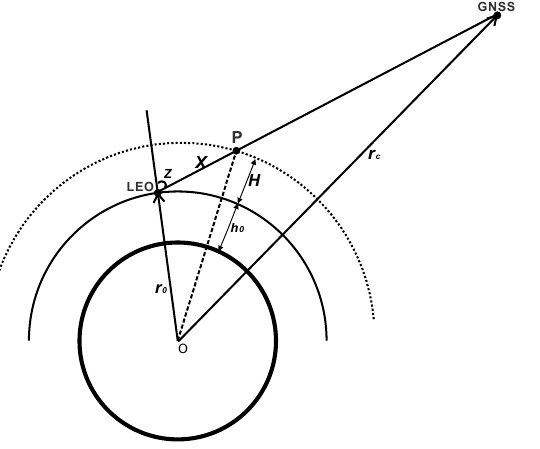
Figure 1. Geometric schematic of LEO-based GNSS TEC mapping model; LEO – low Earth orbit.